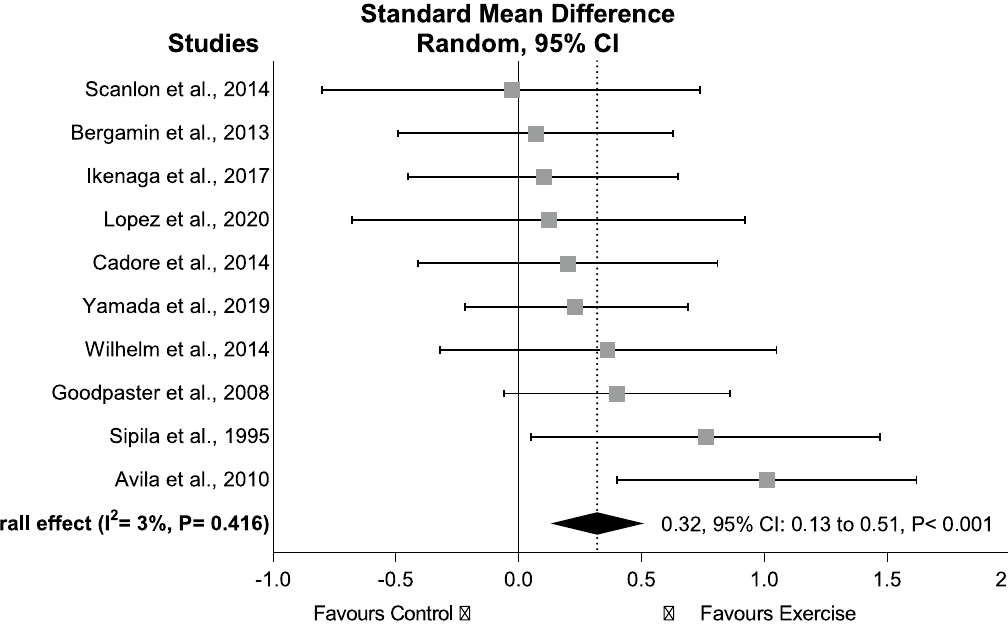
Figure 2. Standardised mean difference effects of exercise compared with control on morphological muscle quality outcomes in older adults. Overall analysis conducted with a random-effects model. Diamond represents pooled standardised mean difference estimate of random-effects meta-analysis; I 2 represents the heterogeneity test; MQ , muscle quality; squares represent study-specific estimates.